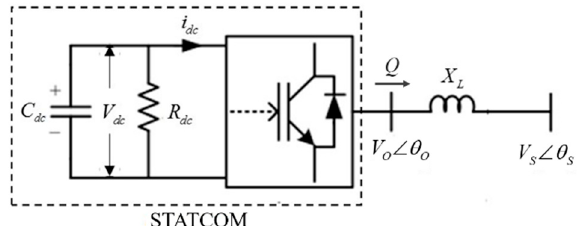
Figure 1. STATCOM single-phase diagram.